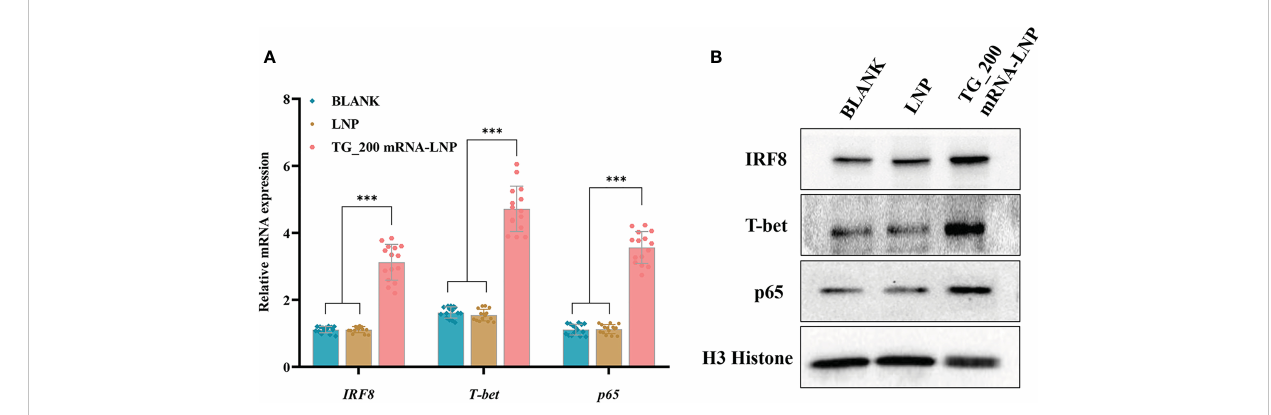
FIGURE 8 The mRNA and protein expression levels of IRF8, T-bet, and p65 in mice splenocytes. (A) mRNA levels of Irf8 , Tbet , and p65 . n = 15/group, *** P< 0.001. (B) Protein levels of IRF8, T-bet, and p65, BLANK: Splenocytes from untreated mice; LNP: Splenocytes lysates from the LNP injected mice; TG_200 mRNA-LNP: Splenocytes lysates from mice injected with TG_200